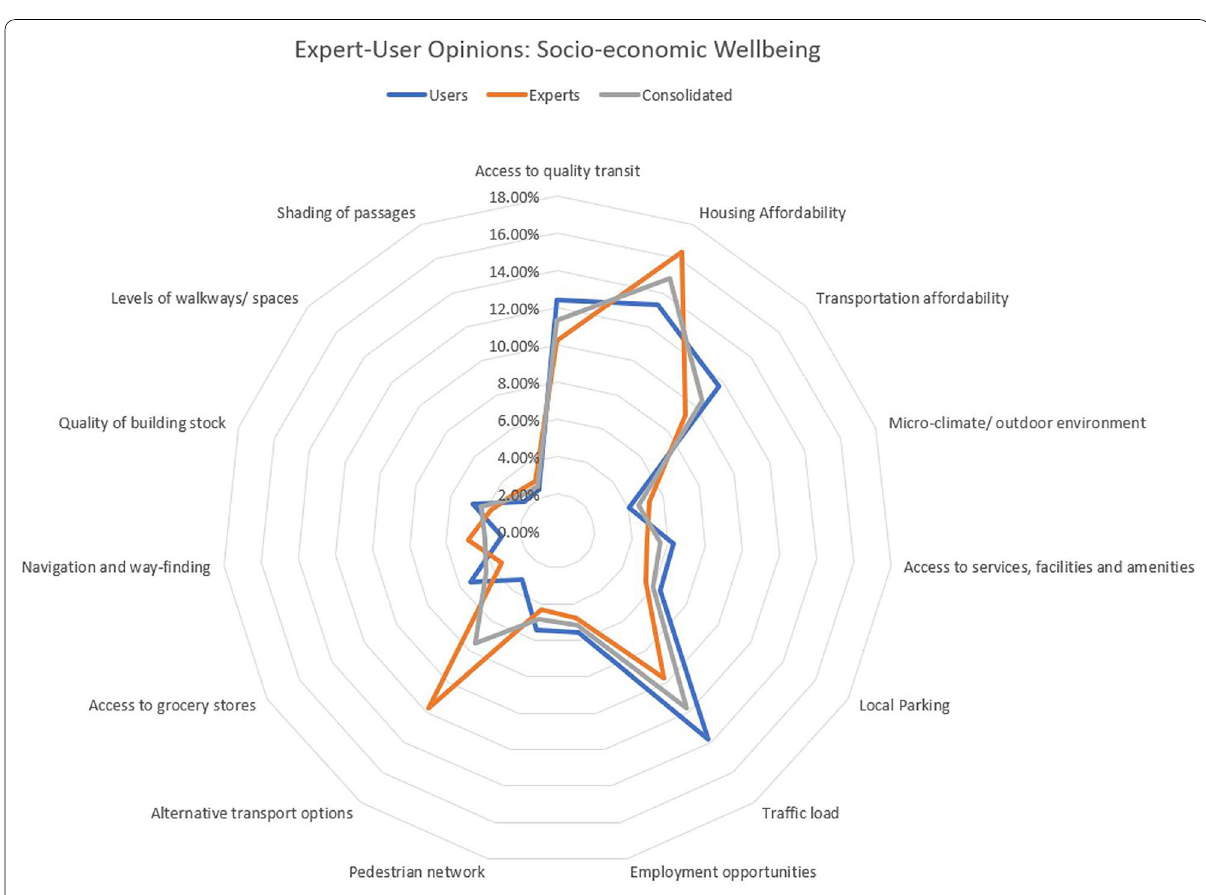
Fig. 5 Comparison between experts and users’ opinions—socio-economic